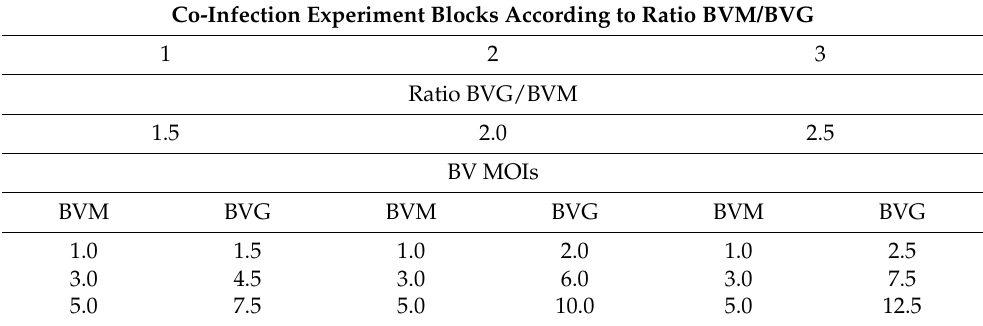
Table 1. The ratio between the MOIs as well as MOI values for BVs used in the co-infection assays. Co-Infection Experiment Blocks According to Ratio